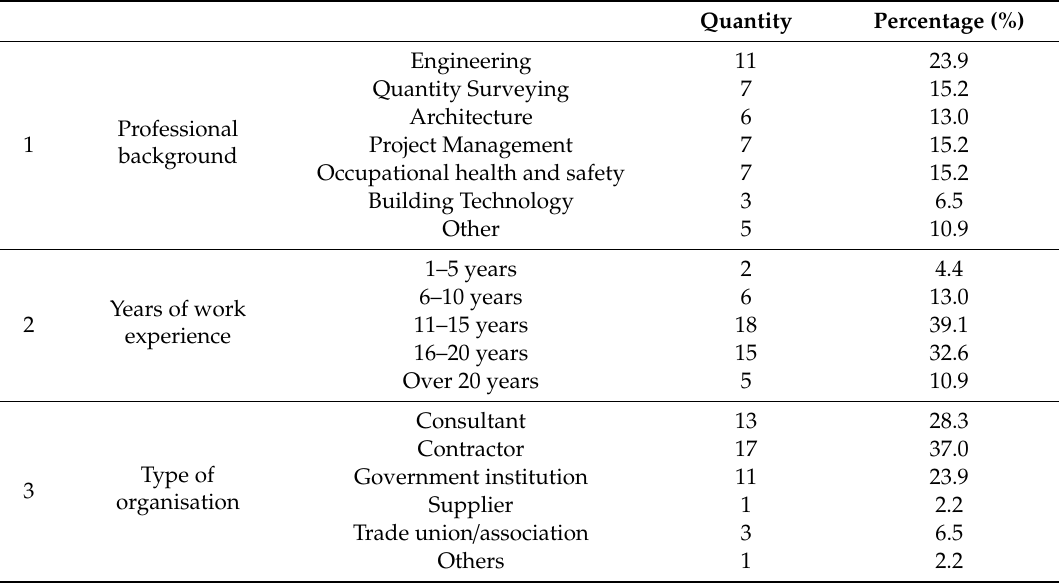
Table 2. Profile of